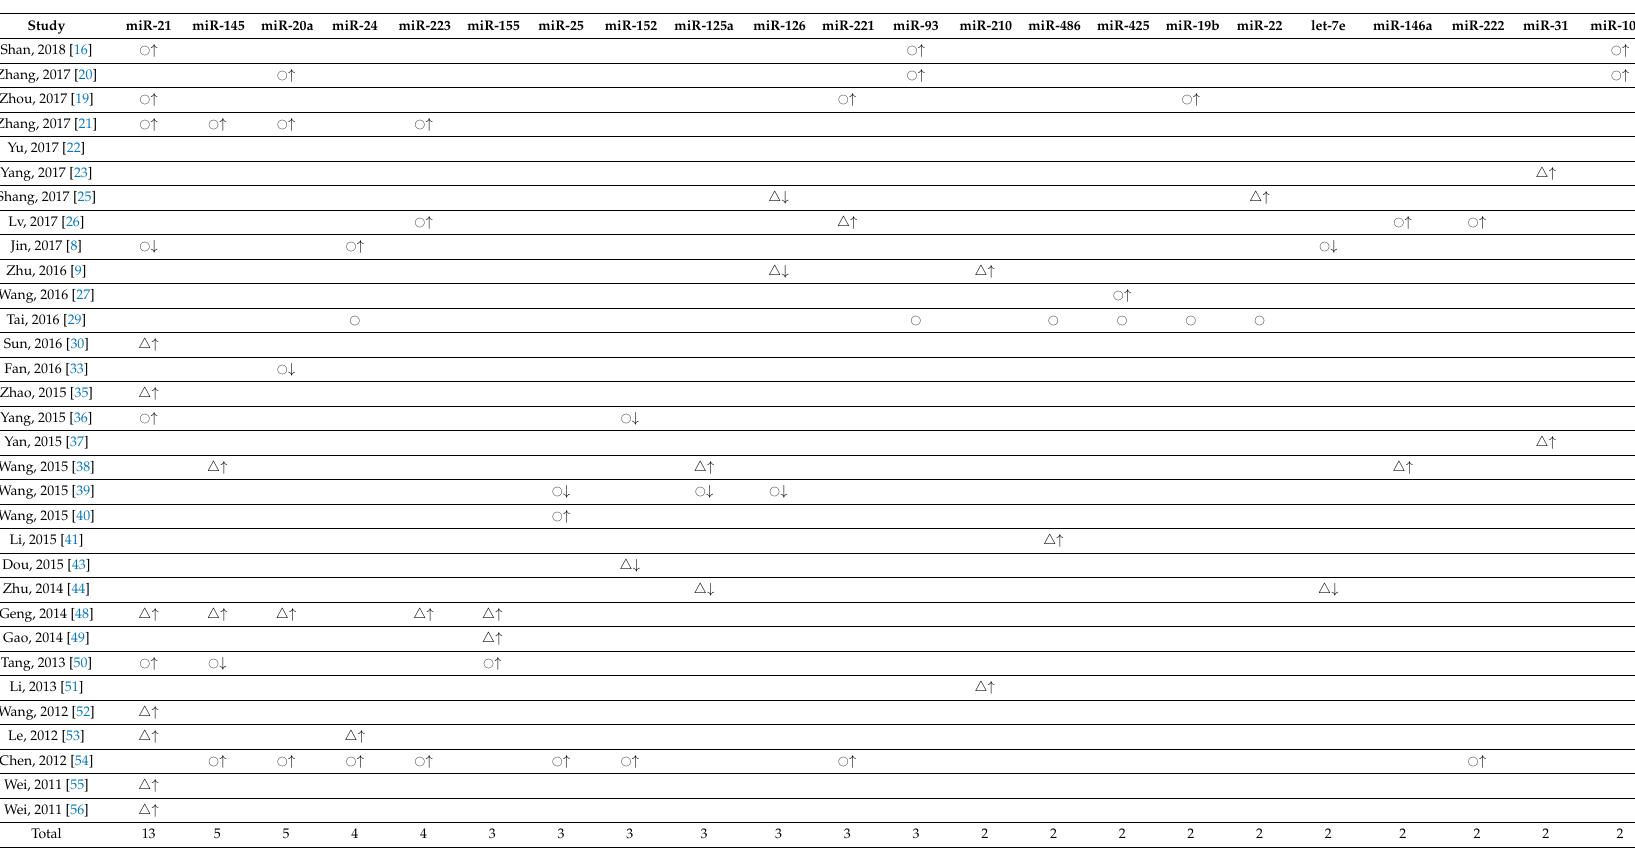
represents miRNAs which are part of a panel; (cid:52) represents miRNAs which have only been analyzed individually and not as a part of a miRNA panel; ↑ represents up-regulation; ↓ represents down-regulation; Table S1 provides all miRNAs for which significant associations with lung cancer have been